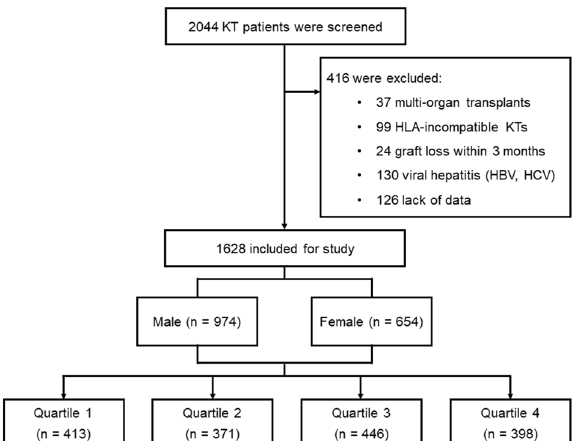
Figure 1. Study flow chart.